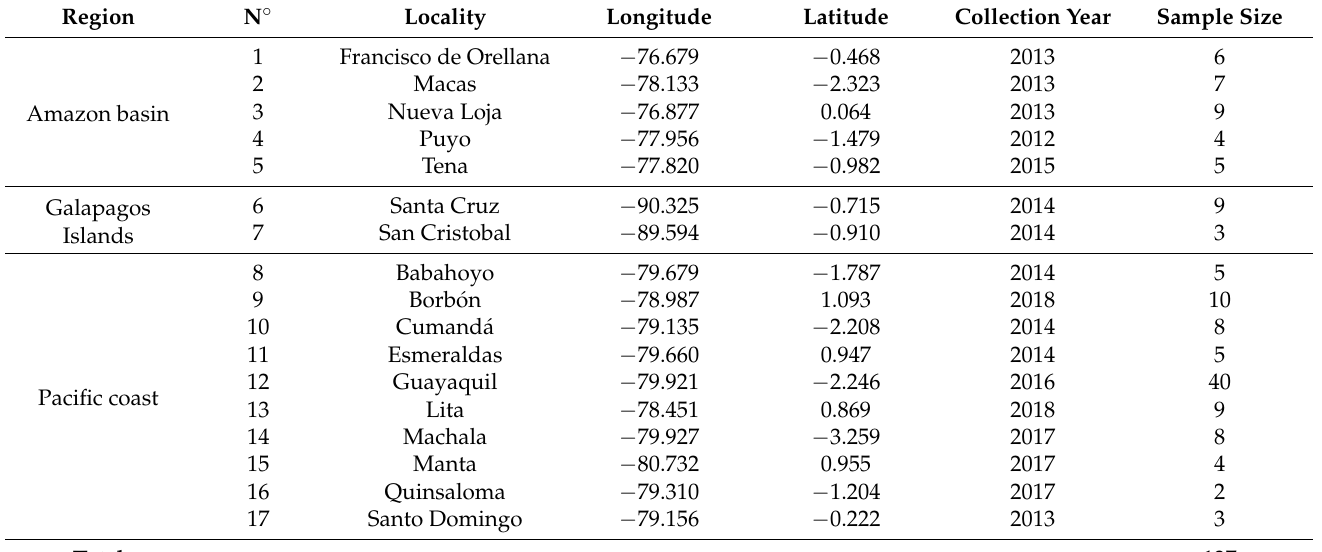
Table 1. Localities were sampled to collect Aedes aegypti individuals from three regions of Ecuador. Region N ◦